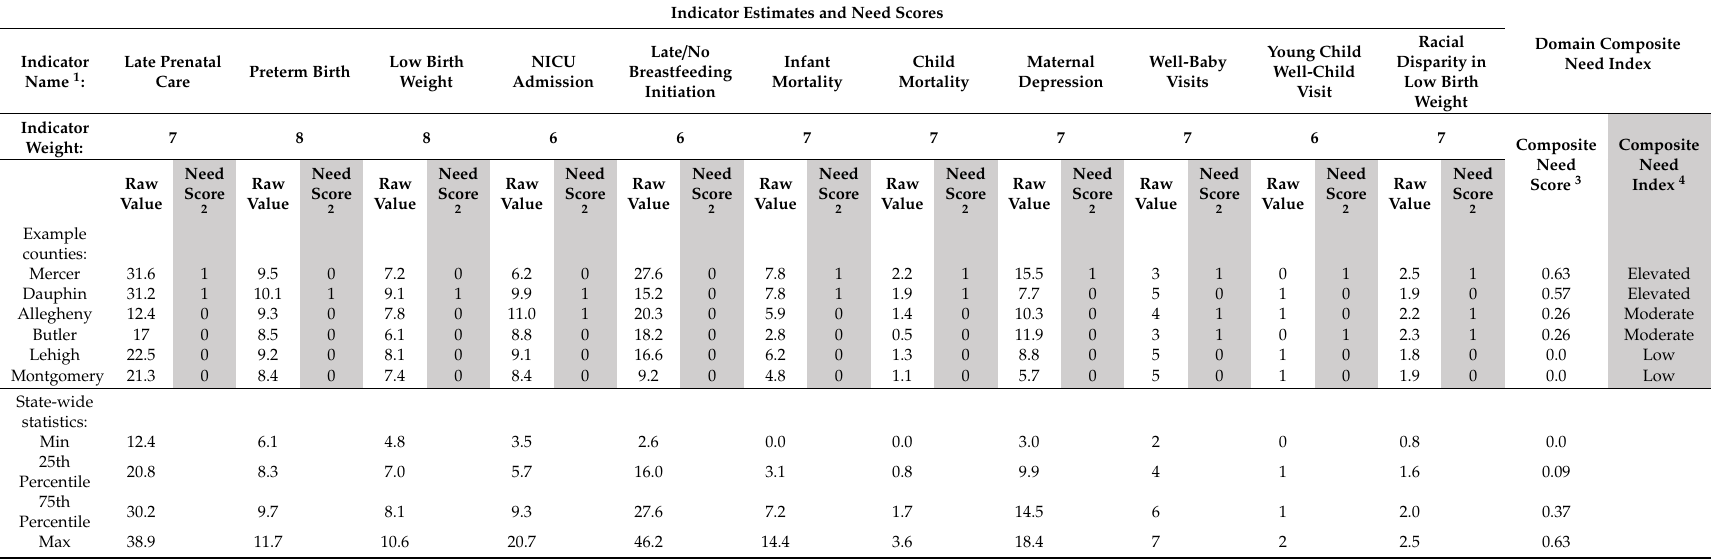
Table 2. Indicator need indices and a composite need index for the domain of perinatal and neonatal outcomes, in 6 example Pennsylvania counties.